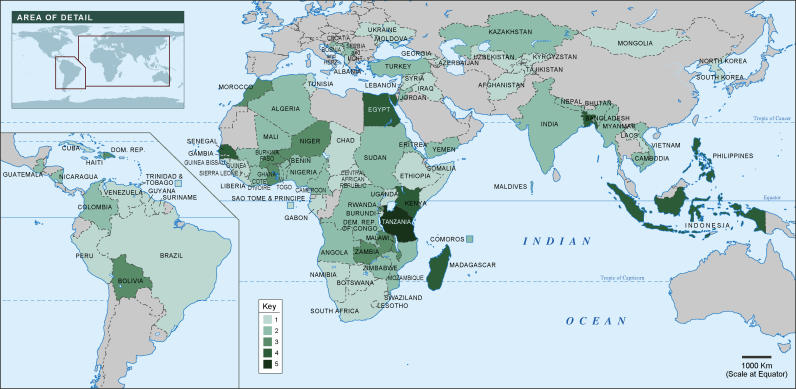
Map of DHS and MICS SurveysThe map shows the number of DHS and MICS surveys by country, 1990–2005, according to completed reports made available to the public in June 2005. These reports are top-level summaries of the underlying micro-level survey data. Note, however, that UNICEF has not publicly disclosed micro-level data for 13 countries (Afghanistan, Algeria, Botswana, Cambodia, Cuba, Georgia, India, the Maldives, Somalia, Syria, Tunisia, Ukraine, and Federal Republic of Yugoslavia), making independent verification of those reports impossible (see http://www.childinfo.org; http://www.measuredhs.com/).(Illustration: Bang Wong, www.clearscience.info)